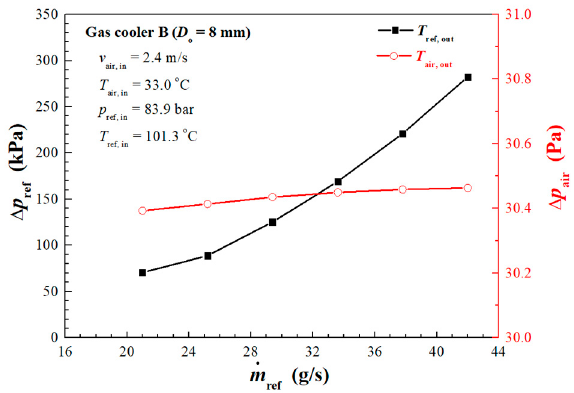
Figure 12. Influence of refrigerant mass flow rate on pressure drop of sCO 2 and air for gas cooler B.